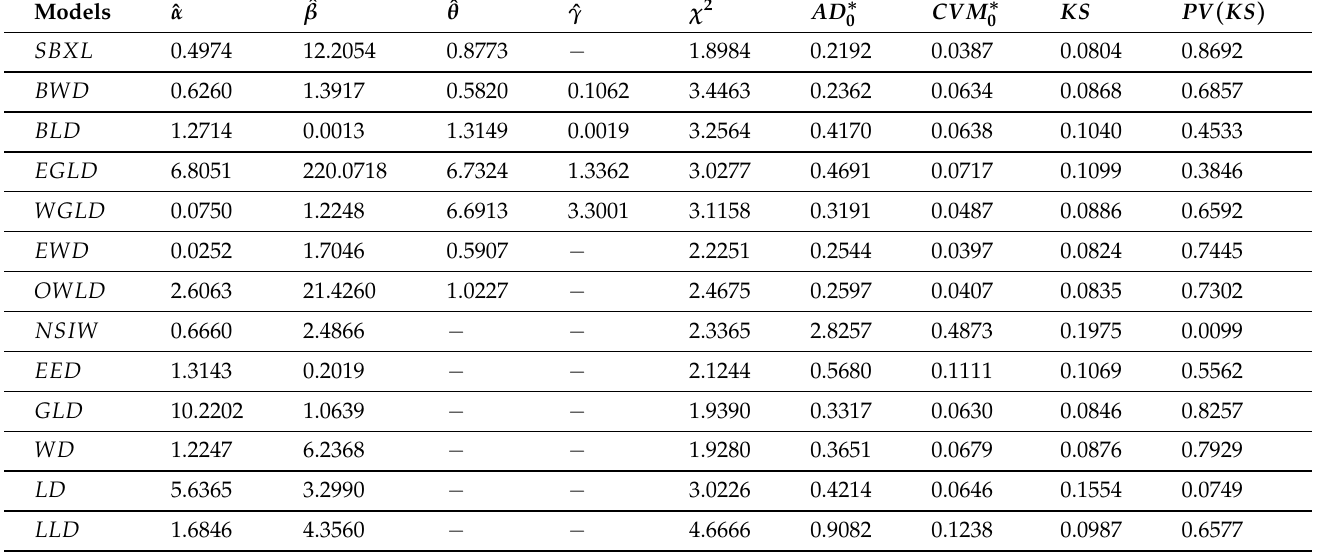
Table 12. MLEs and goodness-of-fit of data set-II.